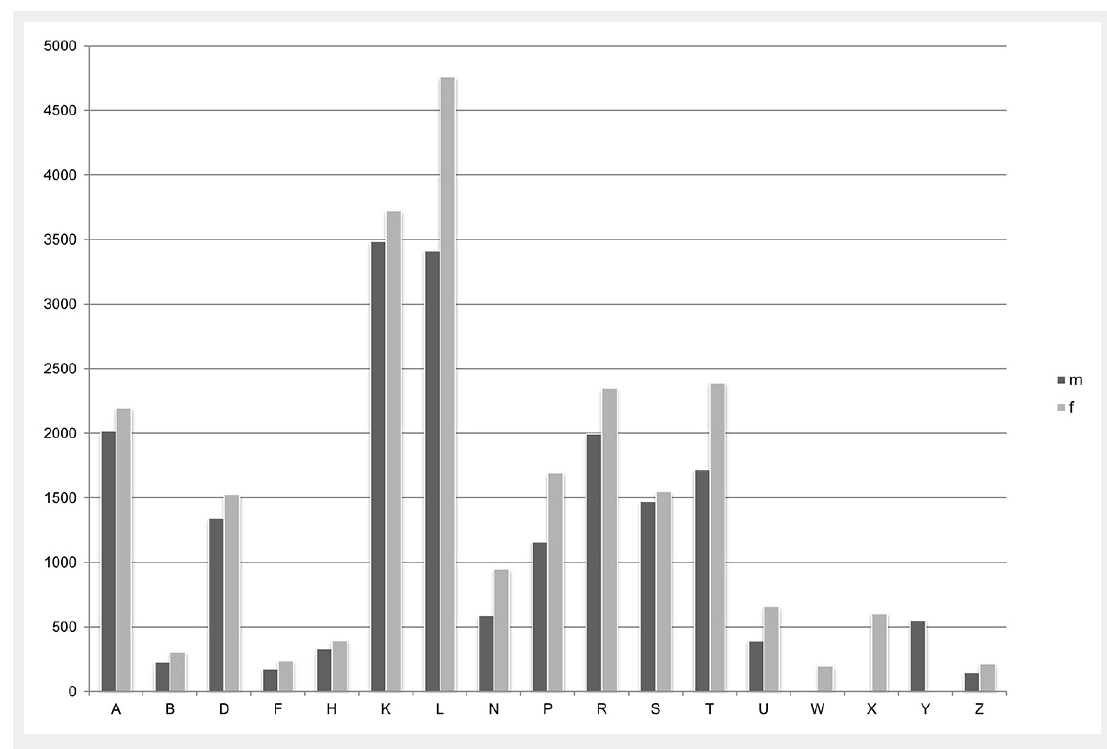
Figure 3 Frequency of RFE in male and female patients. Frequency of reasons for encounter (RFE) according to ICPC-2 chapters in male (dark) and female (light) patients. (A General and unspecified; B Blood, blood forming organs, lymphatics, spleen; D Digestive; F Eye; H Ear; K Circulatory; L Musculoskeletal; N Neurological; P Psychological; R Respiratory; S Skin; T Endocrine, metabolic and nutritional; U Urology; W Pregnancy, childbirth, family planning; X Female genital system and breast; Y Male genital system; Z Social